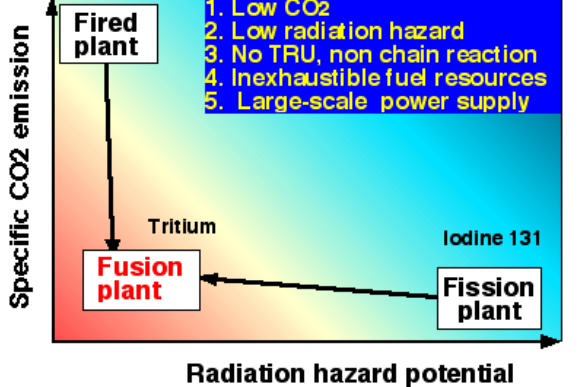
Figure 33. Comparison of fired, fission and fusion on radiation hazard potential and specific CO 2